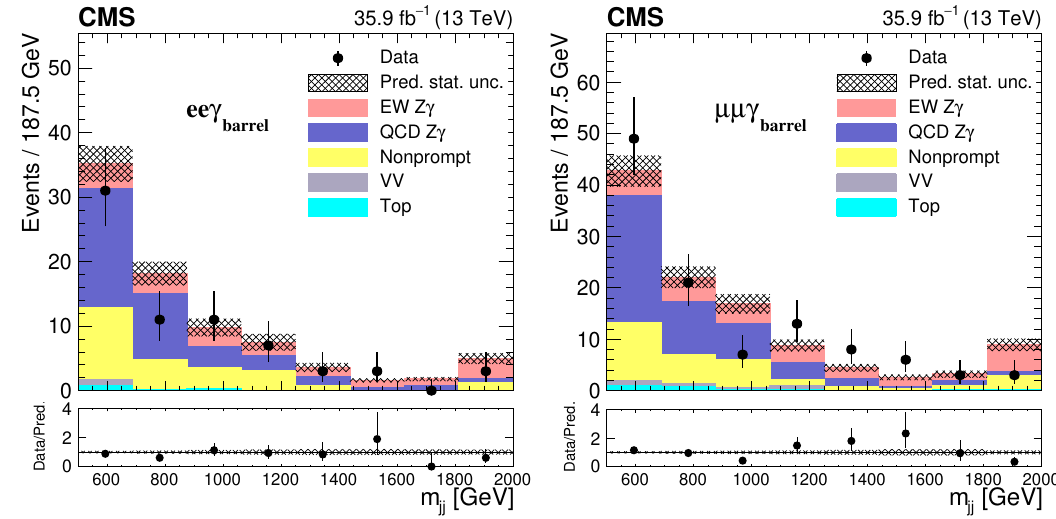
Figure 2 . The pre-(cid:12)t m distributions for the dilepton + (cid:13) events are shown on the left for jj barrel the dielectron and on the right for the dimuon categories. The data are compared to the sum of the signal and the background contribution. The black points with error bars represent the data and their uncertainties, while the hatched bands represent the statistical uncertainty on the combined signal and background expectations. The last bin includes over(cid:13)ow events. The bottom plots show the ratio of the data to the expectation.